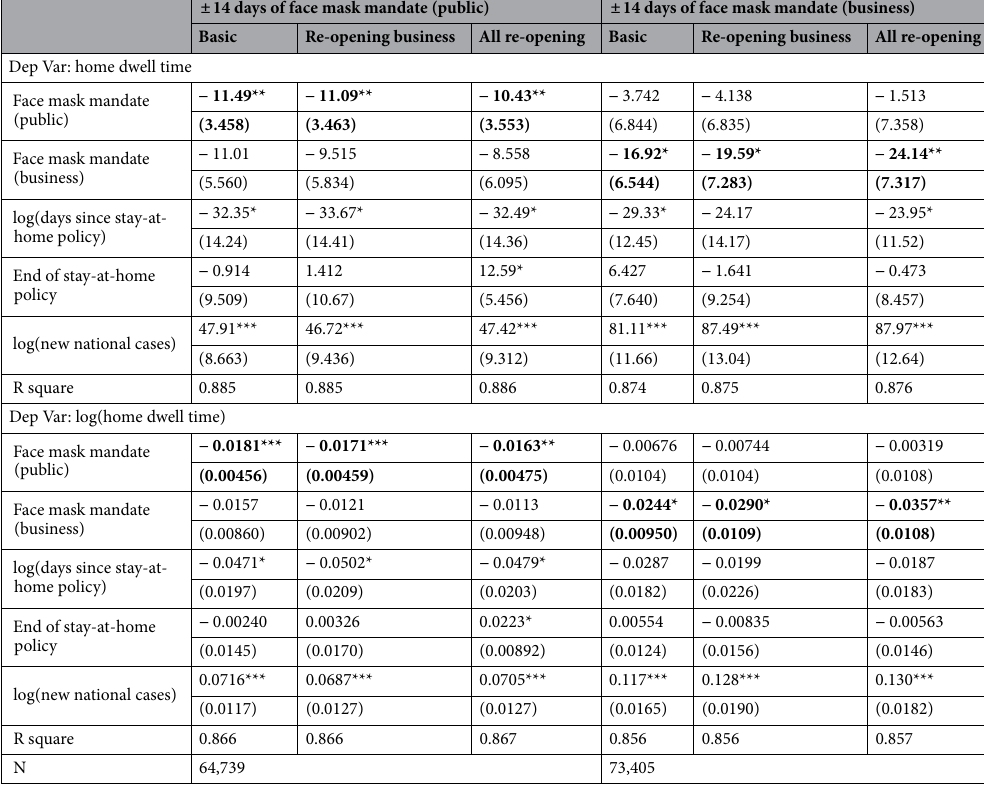
Table 2. Effects of face mask mandates for public and for business on dwelling time at home (in min) in 14 days before and after the mandates. (Only the with-policy counties). Standard errors are presented in parentheses, one, two, and three asterisks refer to the 95%, 99% and 99.9% confidence level. Bold values are parameter estimates of primary interest, γ 1 and γ 2 .